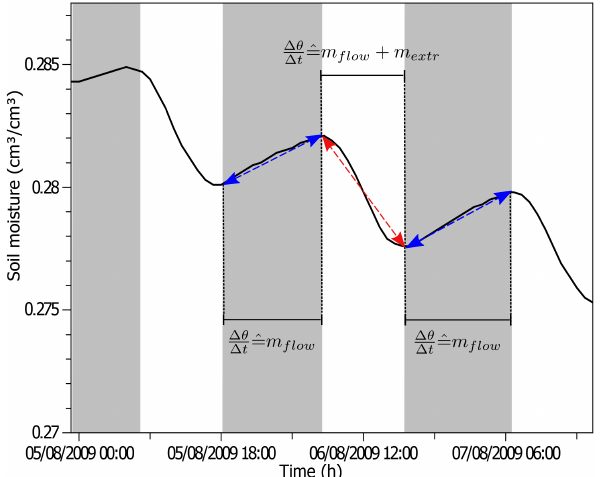
Figure 1. Short-term fluctuations in soil moisture in 15cm depth during August 2009, showing the rewetting of soil at nighttime (blue line) and the water extraction during the day (red line); dashed lines depict the change between times with soil water extraction (white) and rewetting of soil (grey).